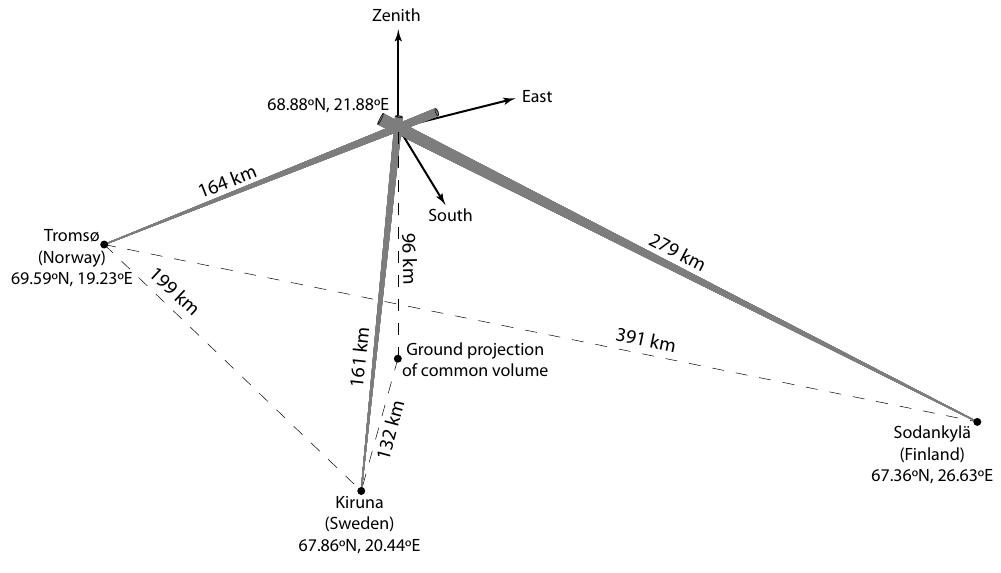
Fig. 1. Sketch of the tetrahedron geometry used in the meteor studies. The full beamwidths are plotted as 1 ◦ and are drawn to scale.